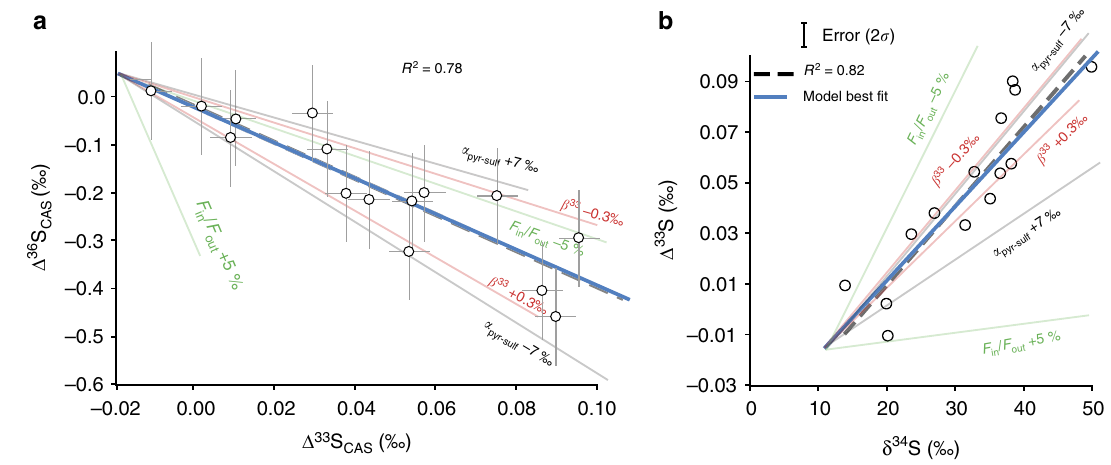
Figure 4 | Sensitivity of the model to small variations of each parameter. ( a ) The D 36 S CAS versus D 33 S CAS diagram and ( b ) the D 33 S CAS versus d 34 S CAS diagram. Changes in F in / F out of ± 5% (green line), in 1,000ln( 34 a ) of ± 7 % (grey line) and in 33 b of ± 0.3 % are tested. The blue line corresponds to the best-fit model and the dashed to the straight line passing through the data. This figure highlights the high sensitivity of the model to all considered parameters (that is, F in / F out , 34 a and 33 b ). Based on duplicate and triplicate analyses, uncertainties of D 33 S and D 36 S values by the SF 6 technique are estimated at 0.01 % and 0.2 % in 2 s , respectively.